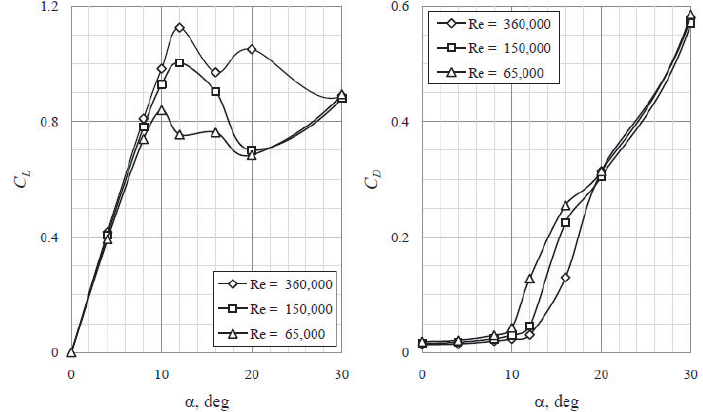
Figure 23. Lift ( left ) and drag ( right ) as a function of AOA at varying Reynolds numbers.